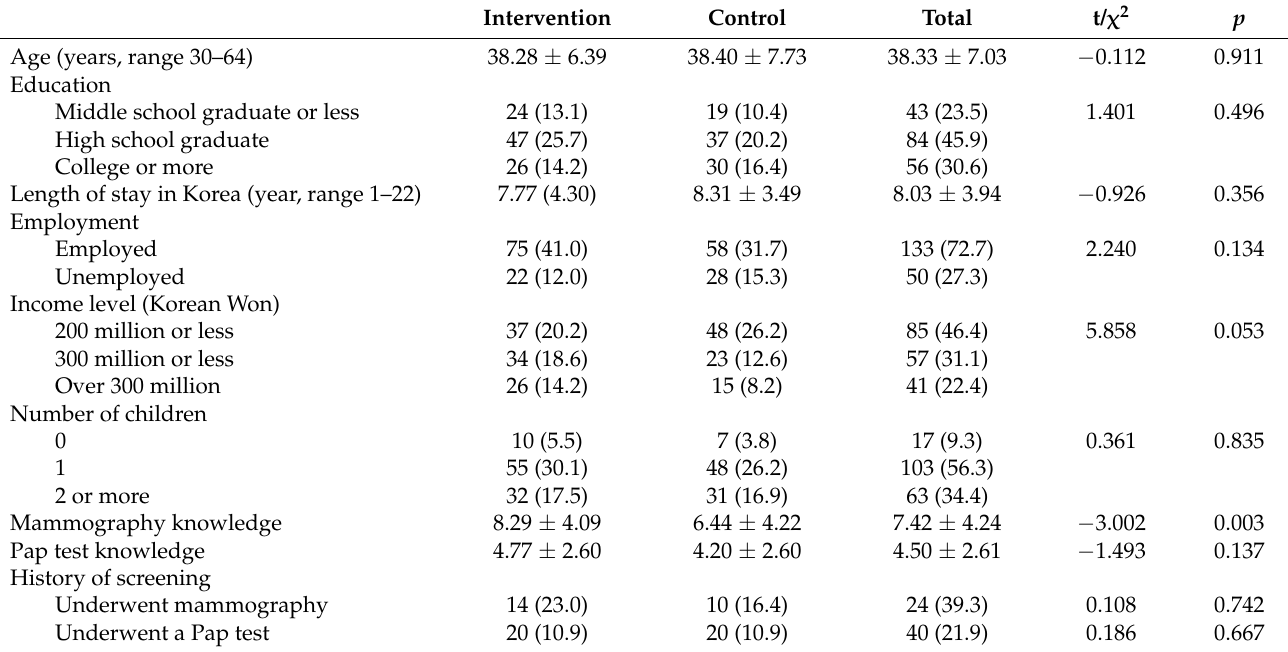
Table 1. Comparison of participants’ general characteristics and outcome variables. Intervention Control Total t/ χ 2